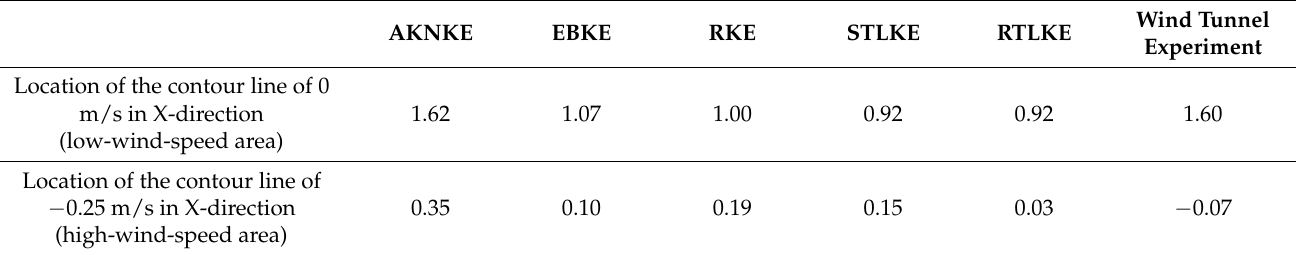
Table 10. Comparison of wind speeds in the low wind-speed area.